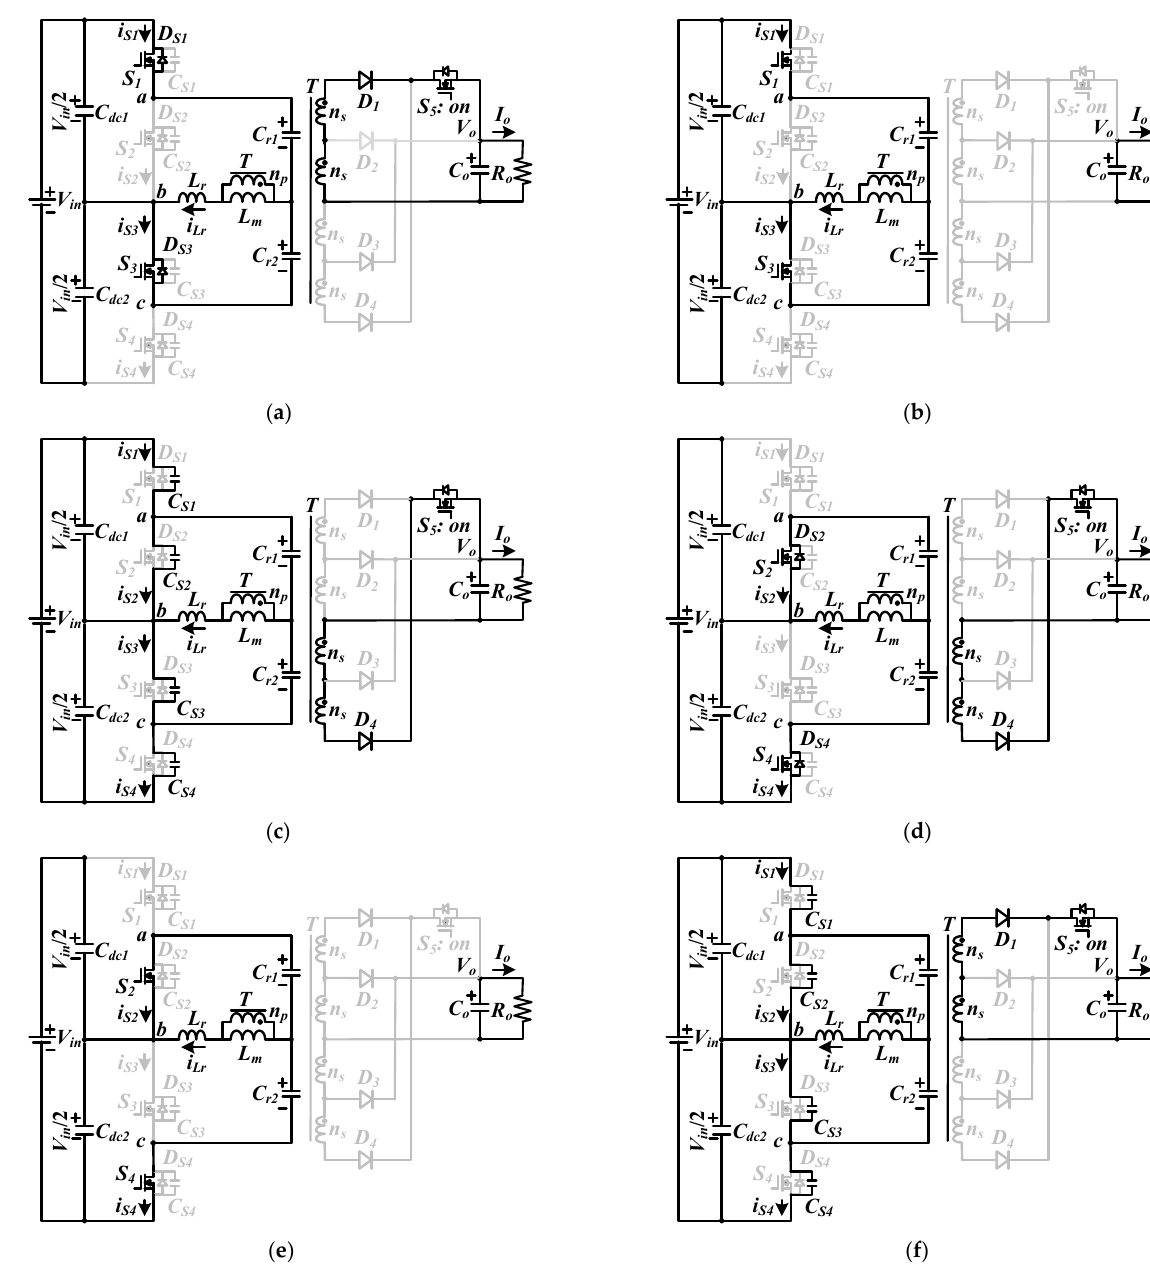
Figure 5. Equivalent mode circuits under high voltage range operation if f sw < f r : ( a ) mode 1 circuit, ( b ) mode 2 circuit, ( c ) mode 3 circuit, ( d ) mode 4 circuit, ( e ) mode 5 circuit, and ( f ) mode 6 circuit.